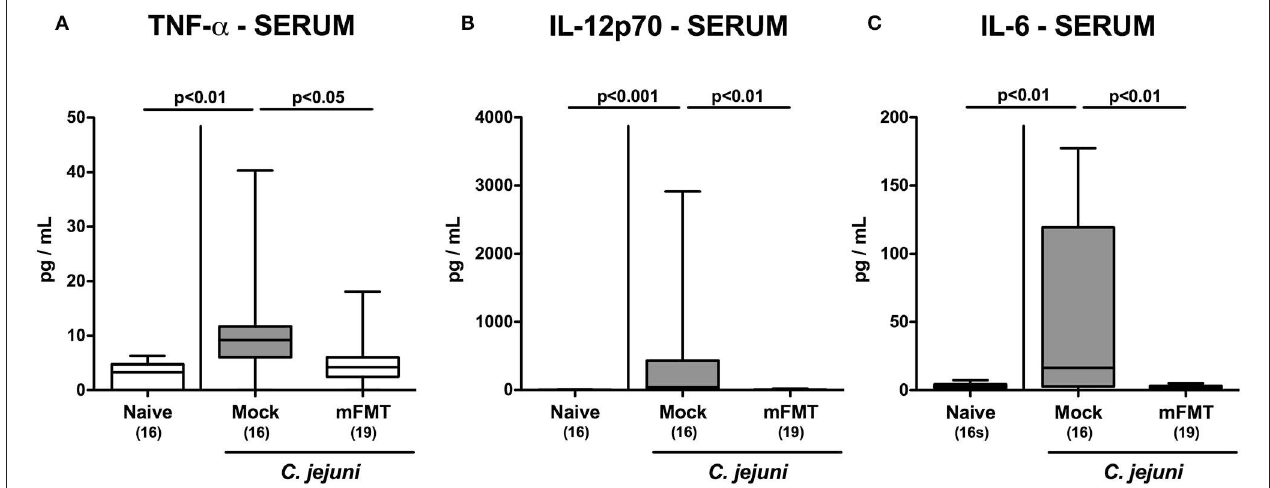
FIGURE 6 | Systemic pro-inflammatory cytokine secretion following murine fecal microbiota transplantation of C. jejuni infected mice harboring a human gut microbiota. Mice with a human gut microbiota were perorally infected with C. jejuni on day (d) 0 and d1 and subjected to murine fecal microbiota transplantation (mFMT) on d7, d8, and d9 post-infection (p.i.) or received vehicle (mock). On day 14 p.i., (A) TNF- α , (B) IL-12p70, and (C) IL-6 concentrations were measured in serum samples. Naive mice with a human gut microbiota served as uninfected and untreated controls. Box plots represent the 75th and 25th percentiles of medians (black bar inside the boxes). The total range, significance levels ( p -values) determined by the one-sided ANOVA test with Tukey post-correction or by the Kruskal-Wallis test and Dunn’s post-correction and the numbers of C. jejuni positive mice out of the total number of animals (in parentheses) are indicated. Data were pooled from four independent